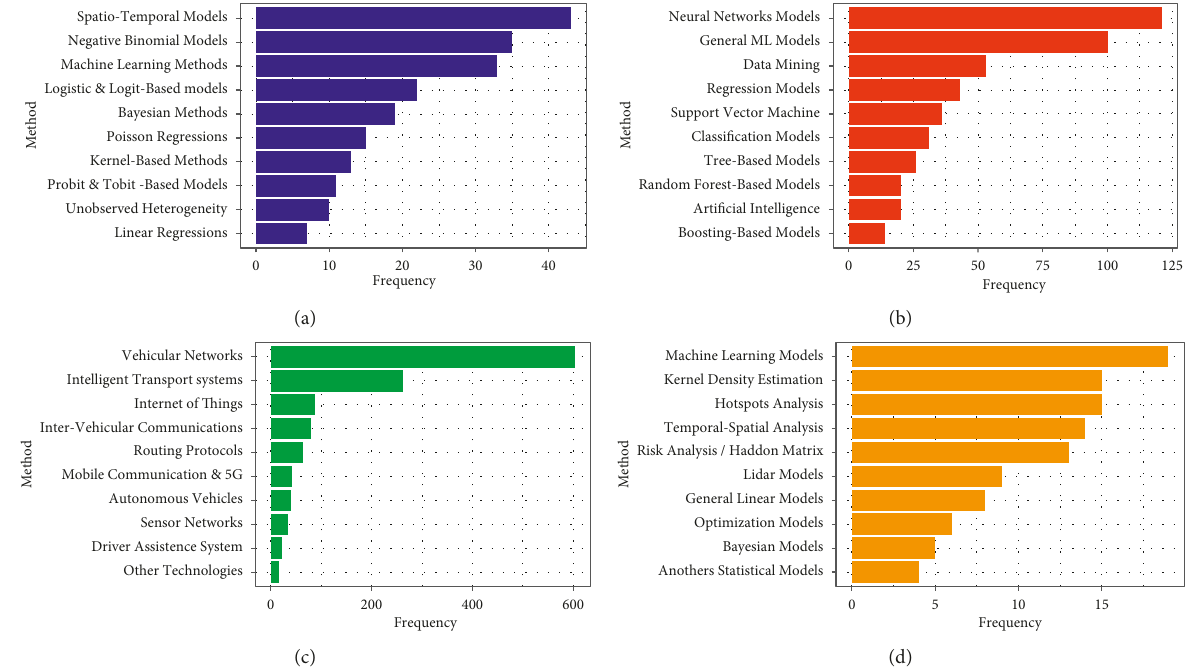
Figure 4: Top-10 methods for analyzing road traffic accidents and highway accidents (a) RTA+HA +SM, (b) RTA+HA +ML, (c) RTA+HA +SC, and (d) RTA+HA +GIS clusters.